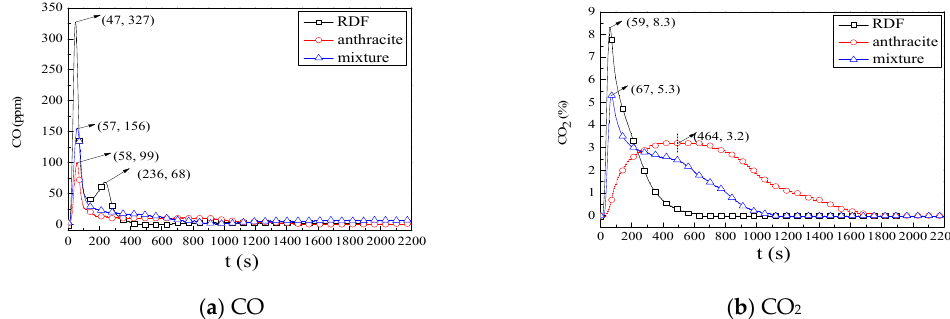
Figure 3. CO and CO 2 emission curves at 900 °C during combustion.